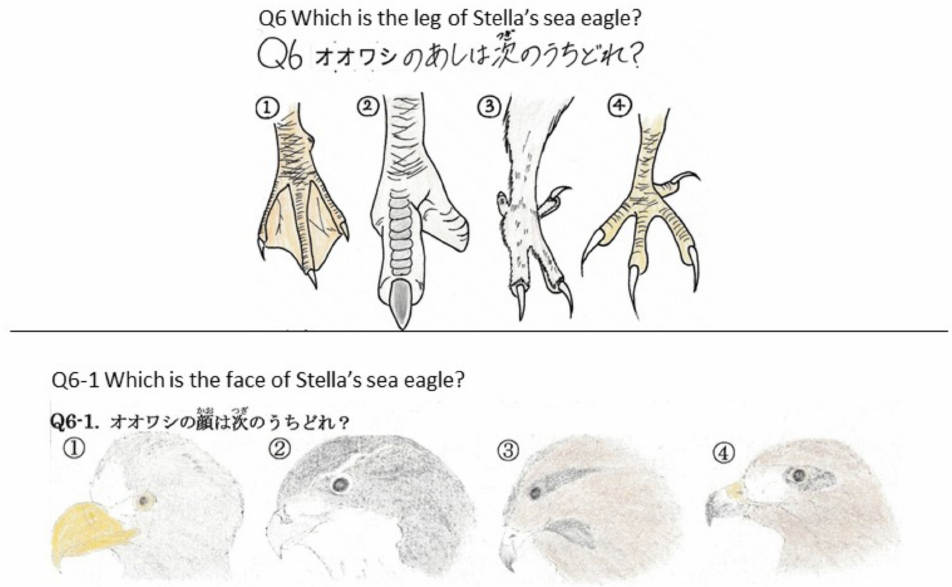
Figure 2. Image of morphological question. Upper image is for the quiz game. Lower image is for evaluation of animal